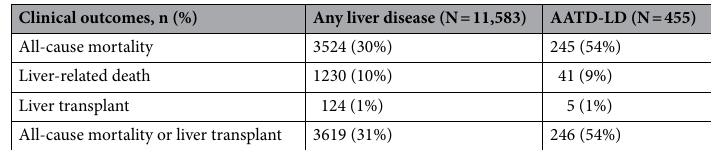
Table 2. Summary of clinical outcomes in patients with any liver disease and AATD-LD.